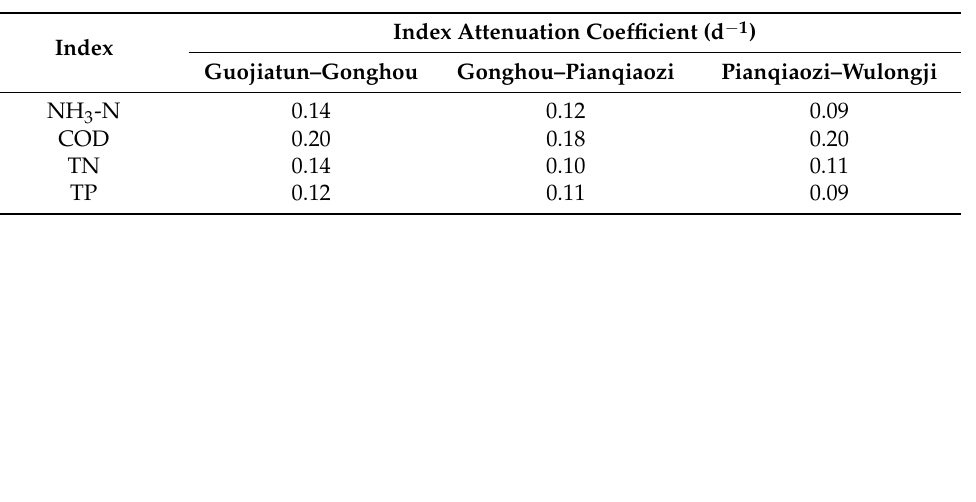
Table A1. Calibration results of the attenuation coefficient of the MIKE11 water quality